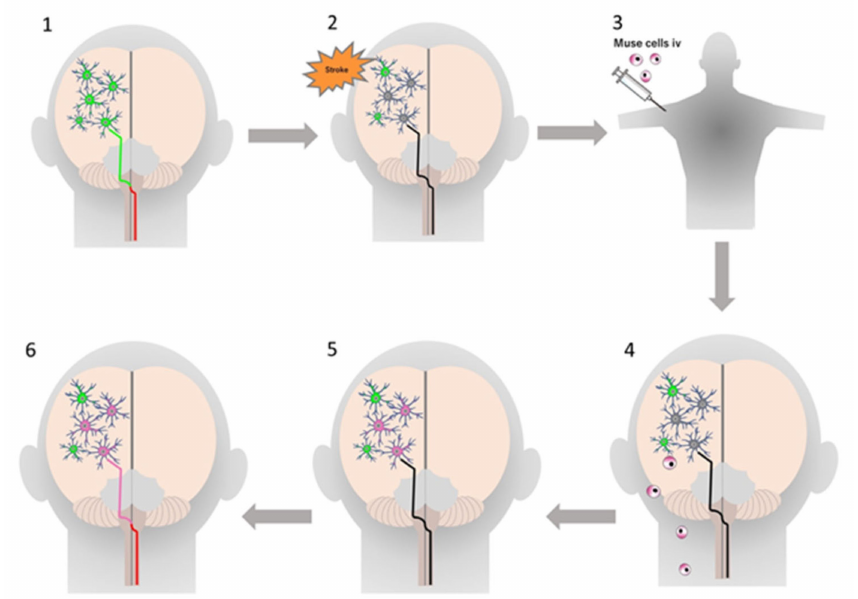
Figure 9. Strategy of Muse cell treatment in stroke. Muse cells selectively home to the post-infarct area in the brain after intravenous injection and spontaneously differentiate into neuronal and glial cells. Differentiated neuronal cells extend neurites that are incorporated into the pyramidal tract, including pyramidal